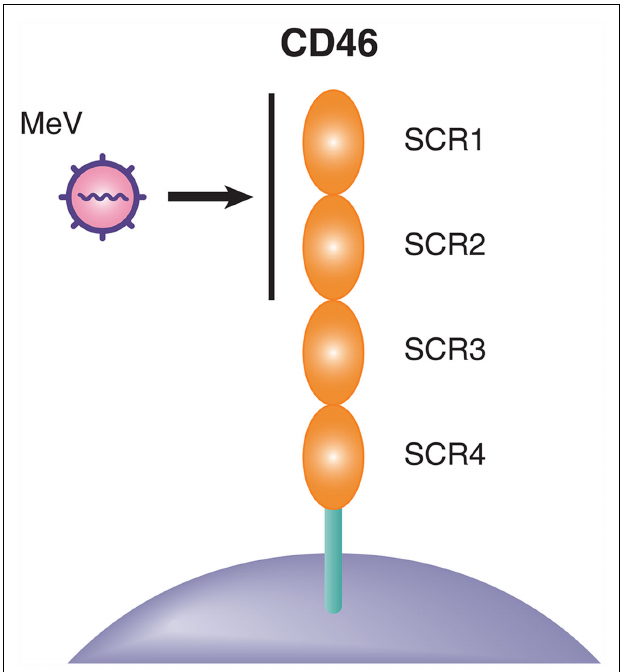
FIGURE 2 | Structure of CD46. CD46 has four SCRs at the amino terminus of its ectodomain. SCR1 and SCR2 interact with the laboratory strains of MeV, whereas SCR3 and SCR4 interact with complement proteins C3b and